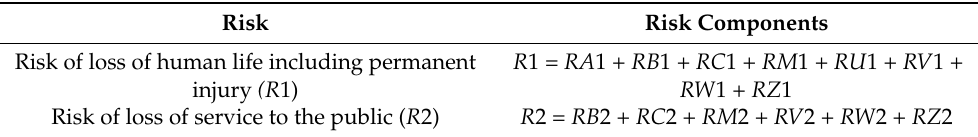
Table 4. Risk Values of R1 and R2 (IEC